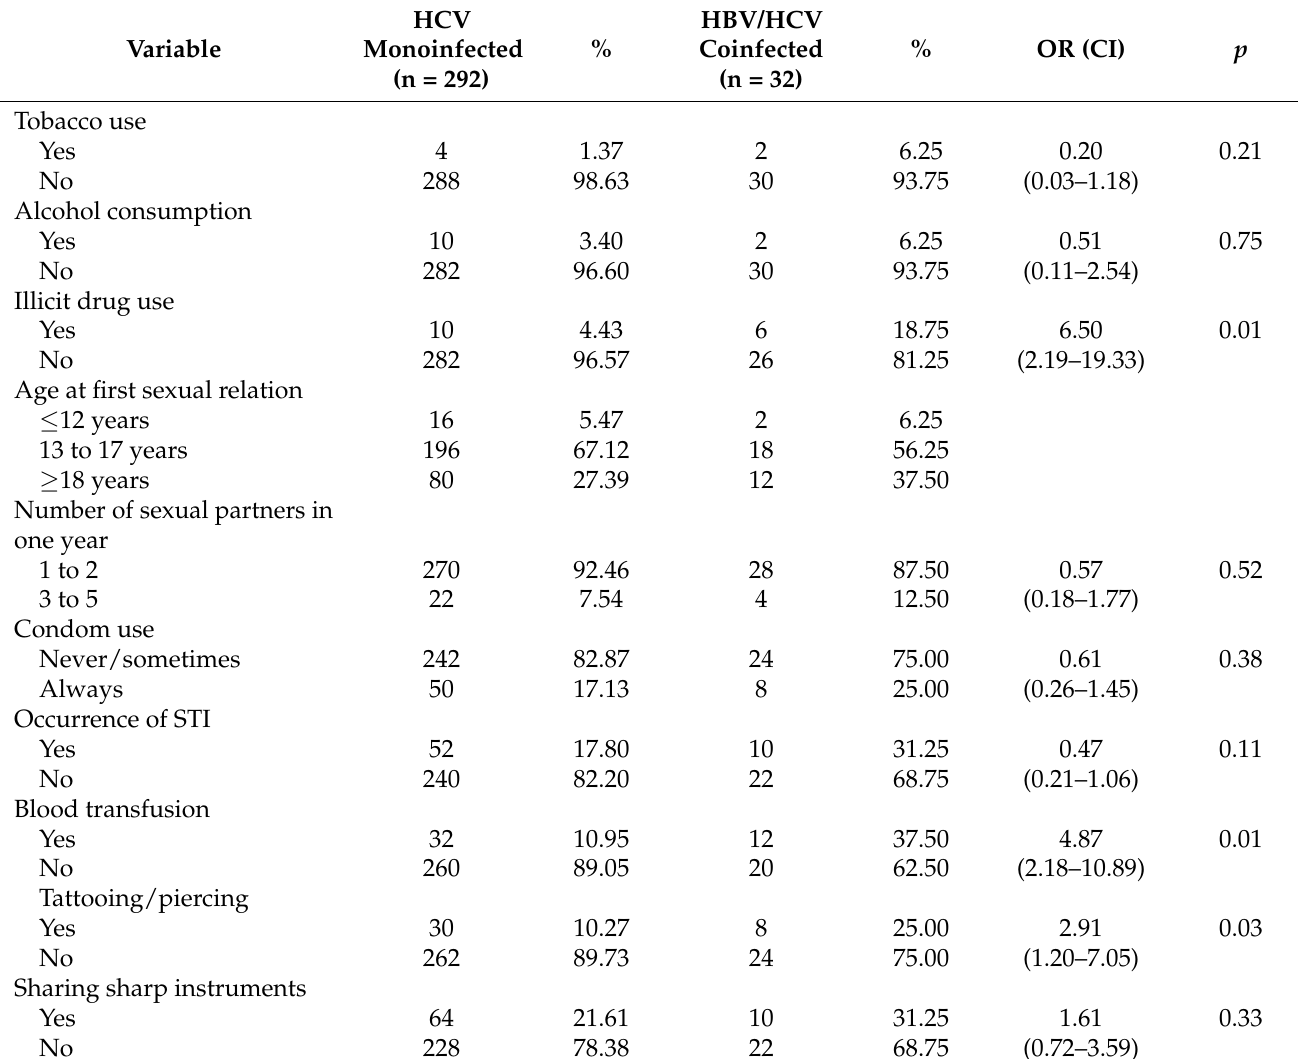
Table 2. Comparison of epidemiological data between HCV-monoinfected and HBV/HCV-coinfected